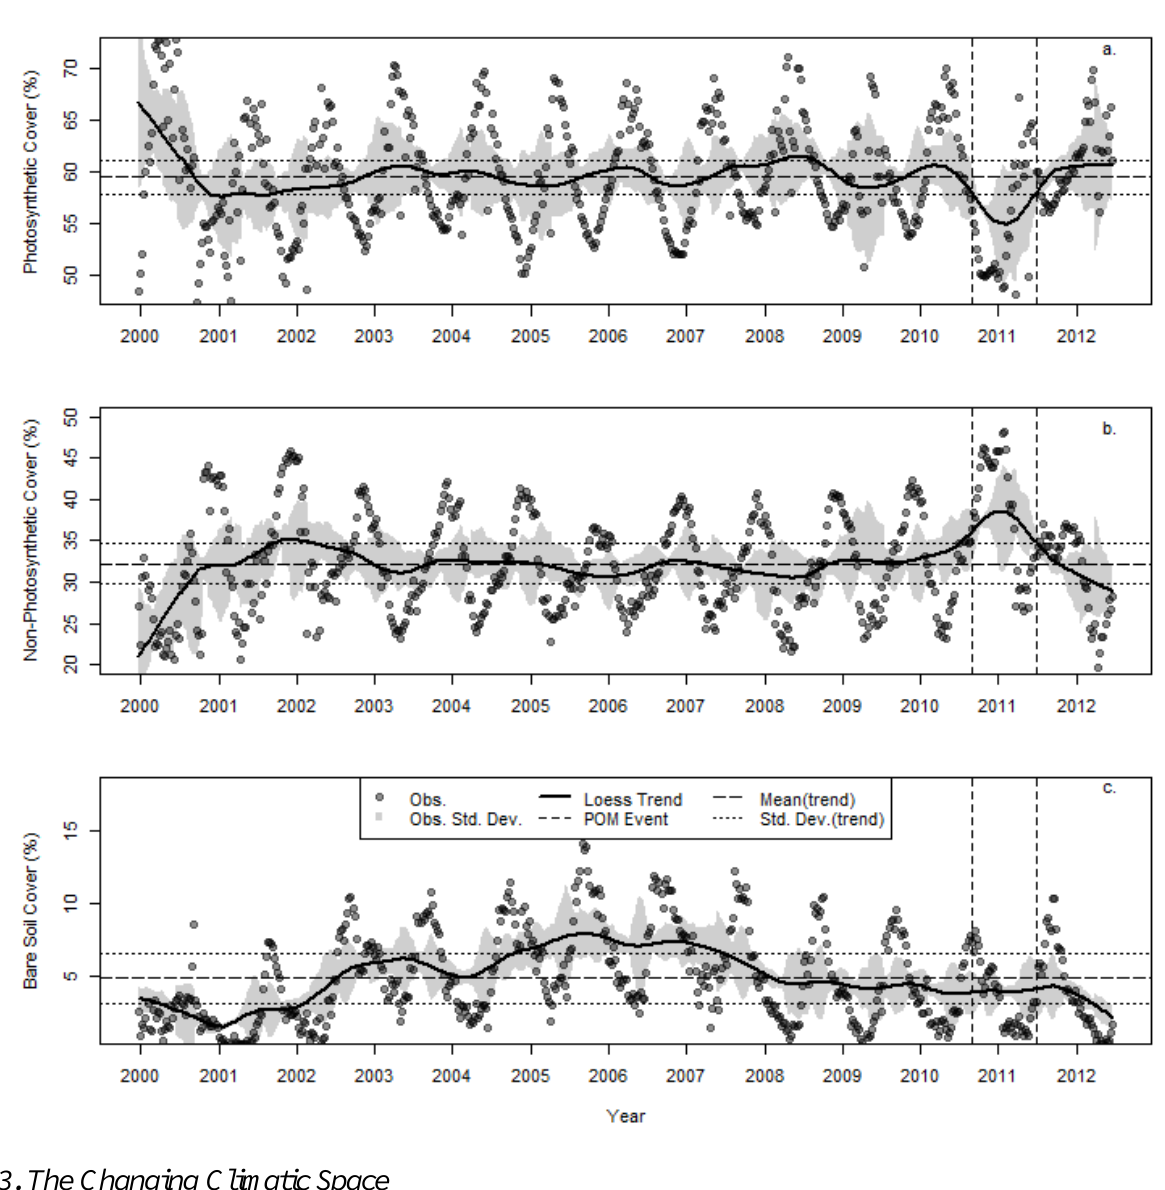
); ( b ) the fraction (%) pv